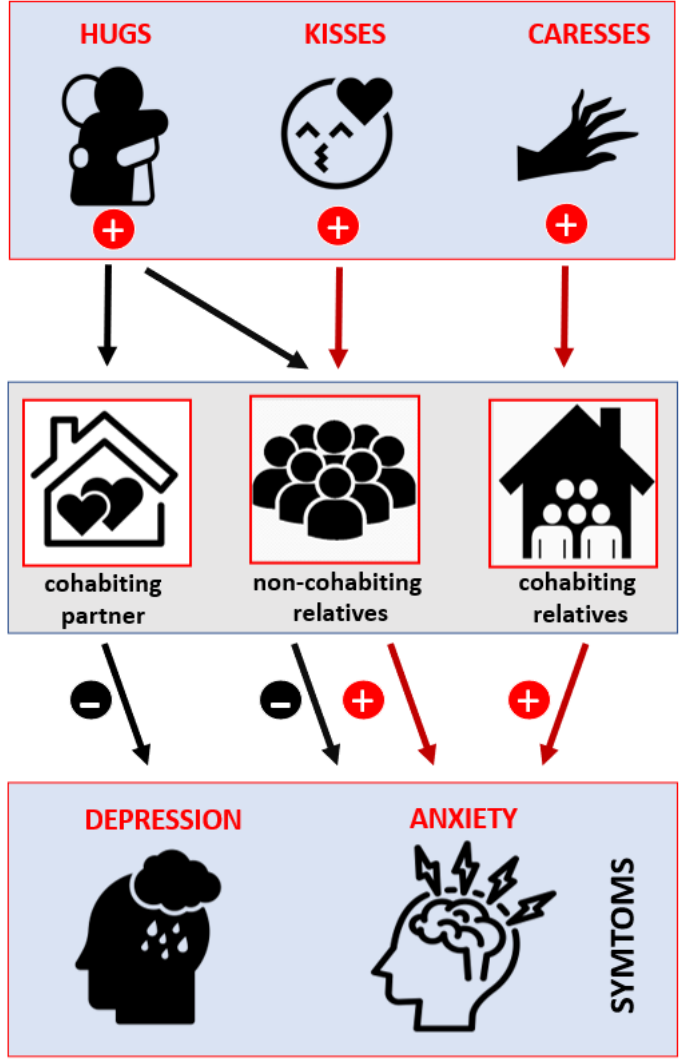
Figure 1. Effects of positive touch on psychological distress during the COVID-19 Pandemic.